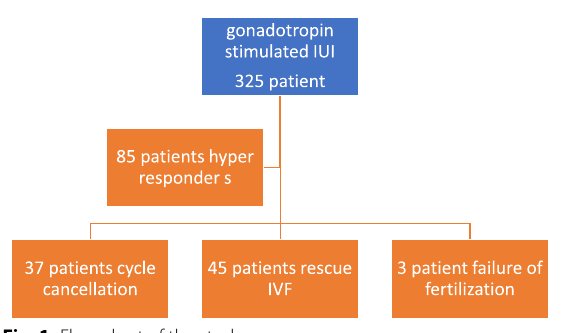
Fig. 1 Flow chart of the study